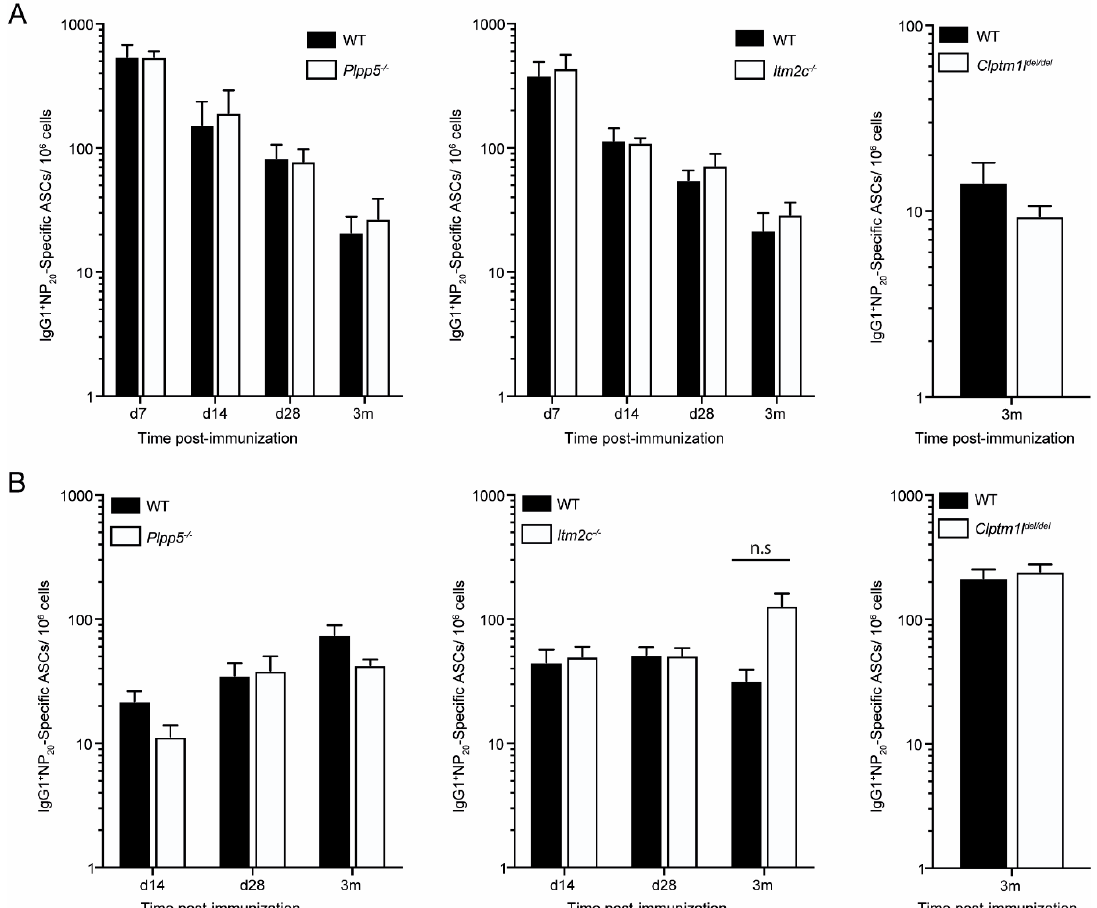
Figure 7. Characterization of the antigen-specific antibody response of Plpp5 − / − Clptm1l del/del and Itm2c − / − mice. Mice were immunized intraperitoneally with NP-KLH in alum and, at the indicated time post-immunization, the number of NP20-specific IgG1+ ASCs in the ( A ) spleen and ( B ) BM was determined by ELISpot. Plpp5 data are combined from three independent experiments at each time point where n = 3–6. Itm2c data are combined from 1 (day (d) 7) or 2 (d14, d28, 3 months (m)) independent experiments where n = 3–4. Clptm1l data are from 1 experiment where n = 4. Data are the mean ±SEM. Statistical significance was analyzed using unpaired t-test, correcting for multiple comparisons. n.s., not significant ( p > 0.05).